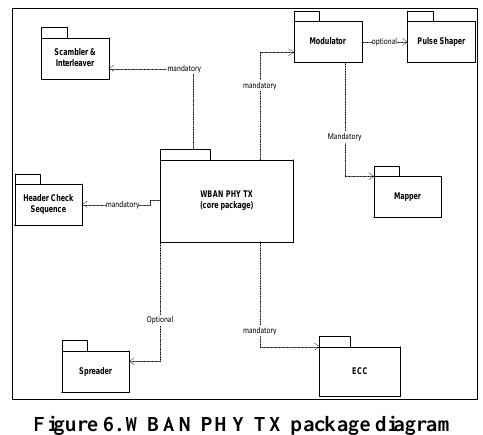
Figure 6. WBAN PHY TX package diagram